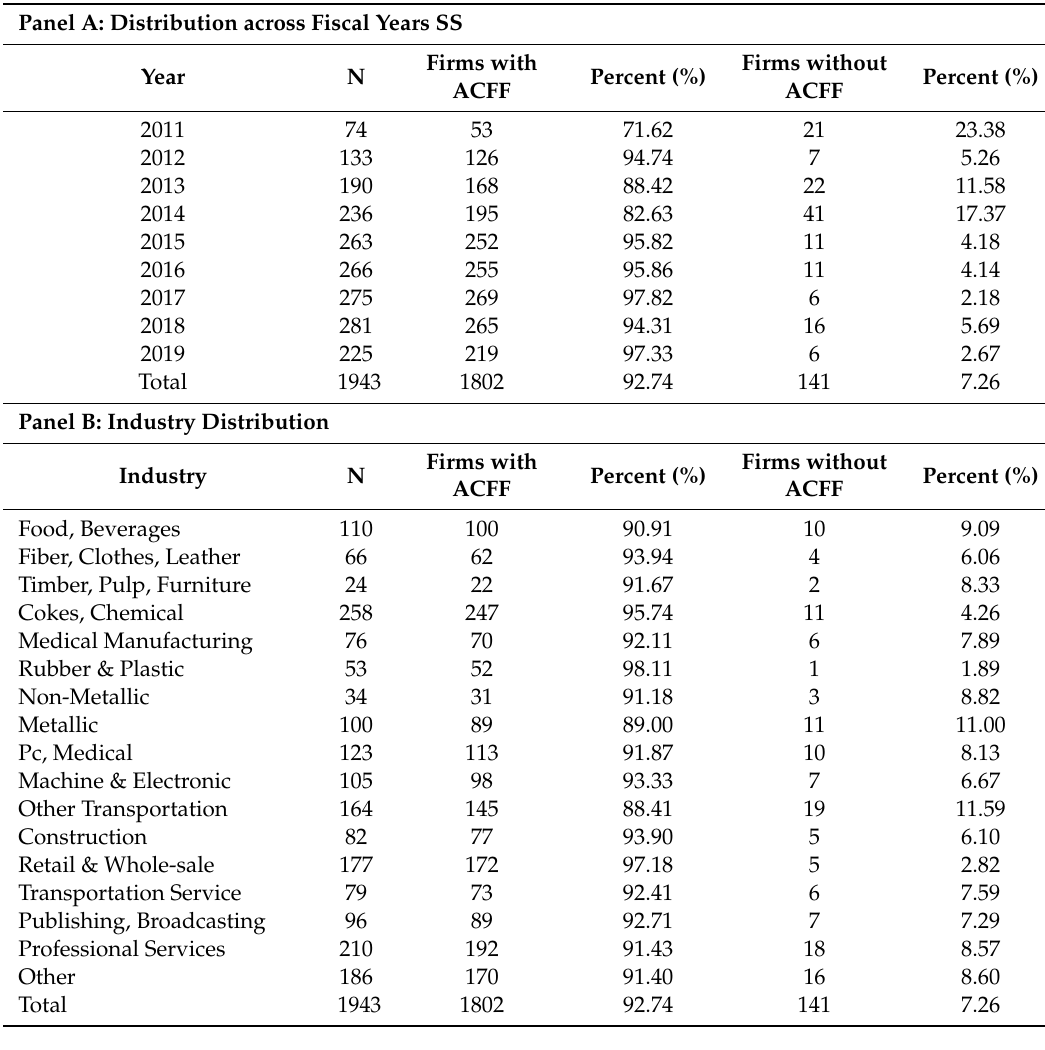
Table 2. Distribution during sample